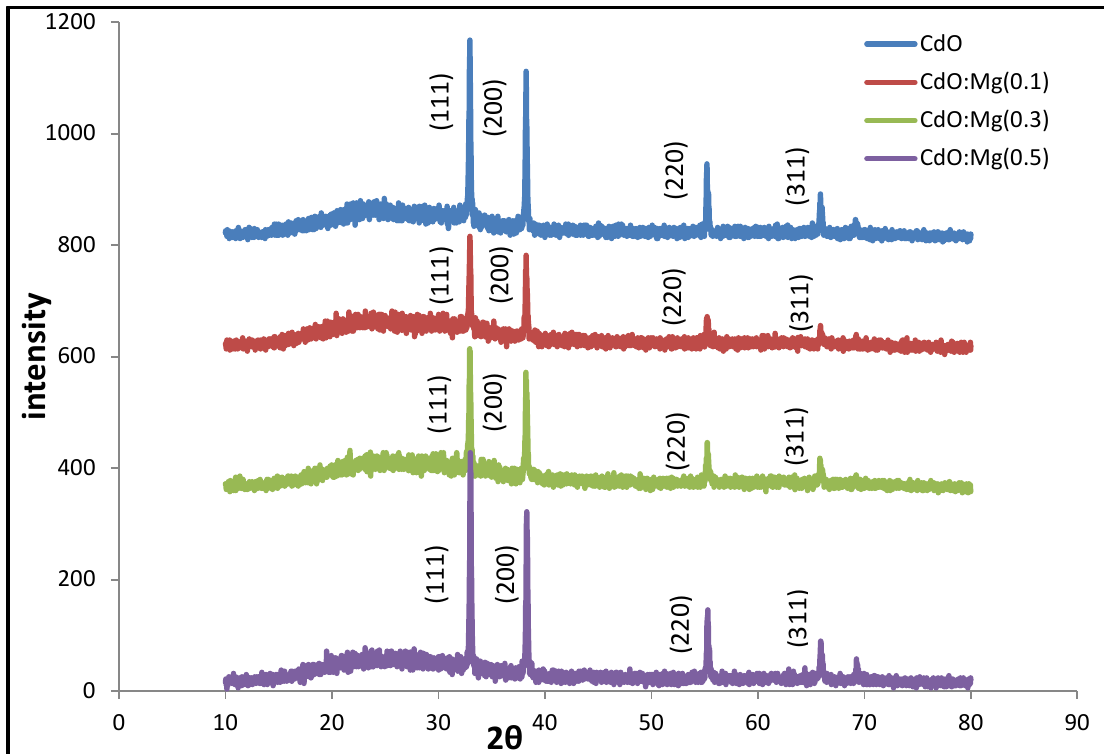
Fig. 2: X-ray diffraction pattern for CdO: Mg films.